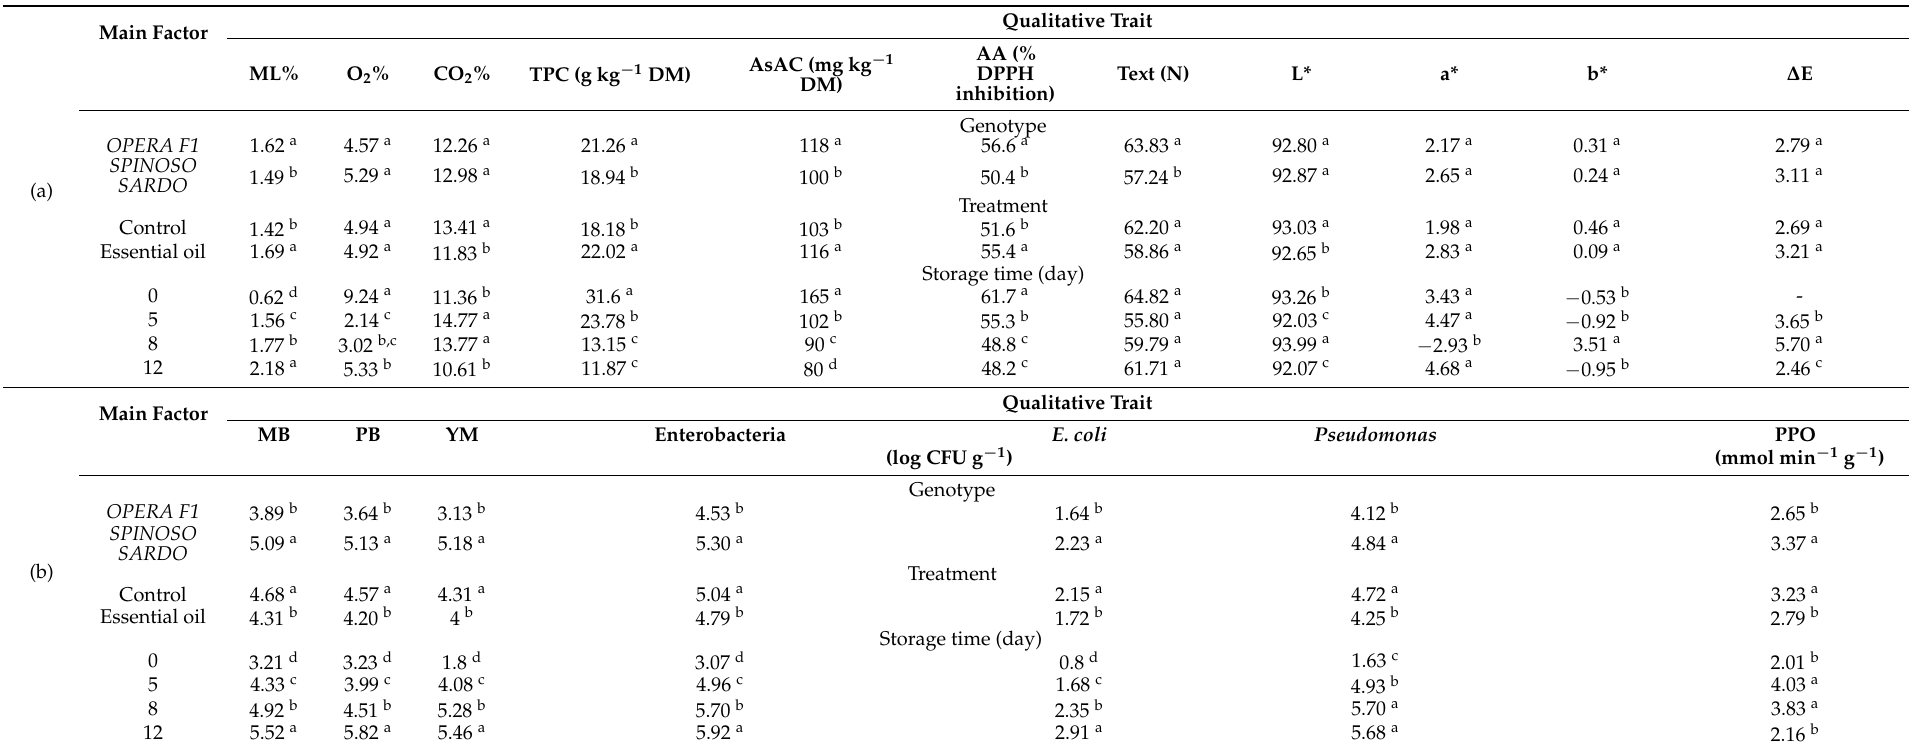
Table 2. Qualitative traits of ready-to-cook (RTC) globe artichoke slices as affected by the main factors under